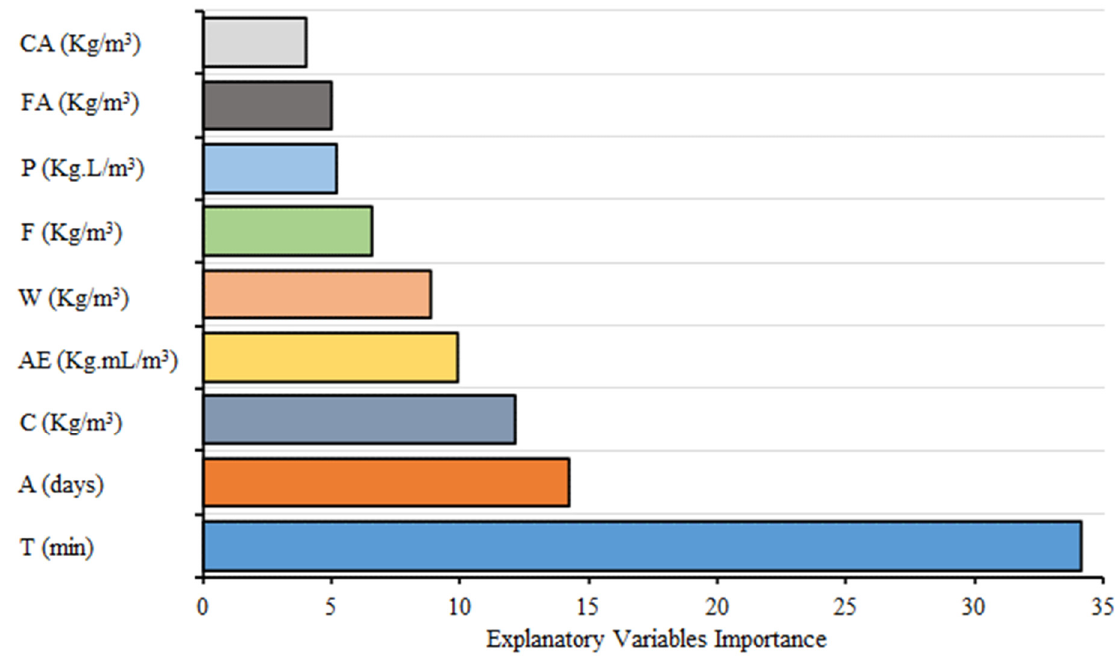
Figure 9. Importance of explanatory variables on the wear depth of